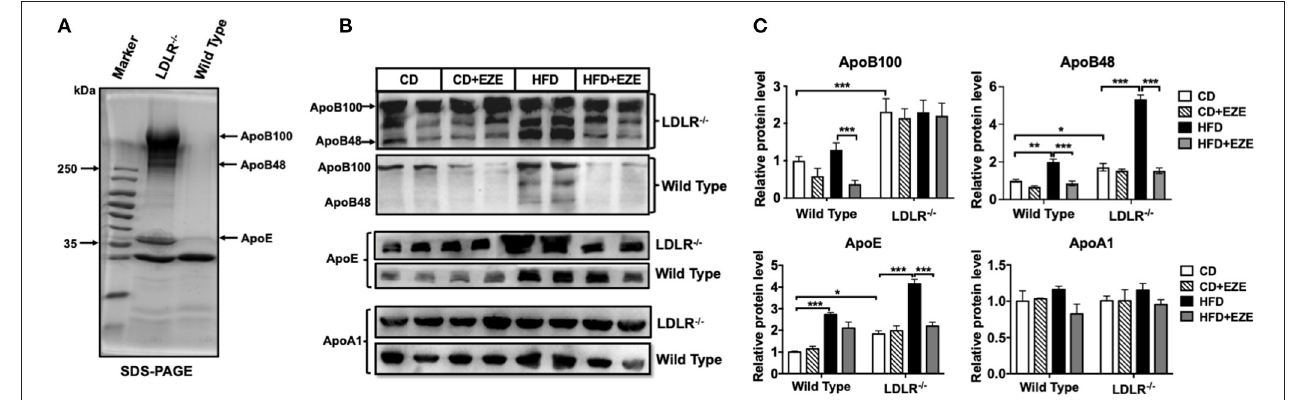
FIGURE 2 | Apolipoproteins of TRLs were analyzed by SDS-PAGE (A) and western blotting (B) for ApoB, ApoE, and ApoAI in plasma of LDLR − / − and WT hamsters with or without HFD and ezetimibe treatment after 2 weeks. (C) Is the quantitative bar chart analysis for (B) , the relative protein level was ratio to the CD group of WT hamsters. Separated TRLs from the plasma of fasted hamsters fed a CD were used for SDS-PAGE analysis. For each sample, 1 µ L of plasma was used for analysis. Data are shown as mean ± SEM. Three-way ANOVA with Tukey’s multiple comparison test, *, **, *** represent p < 0.05, 0.01, and 0.001,